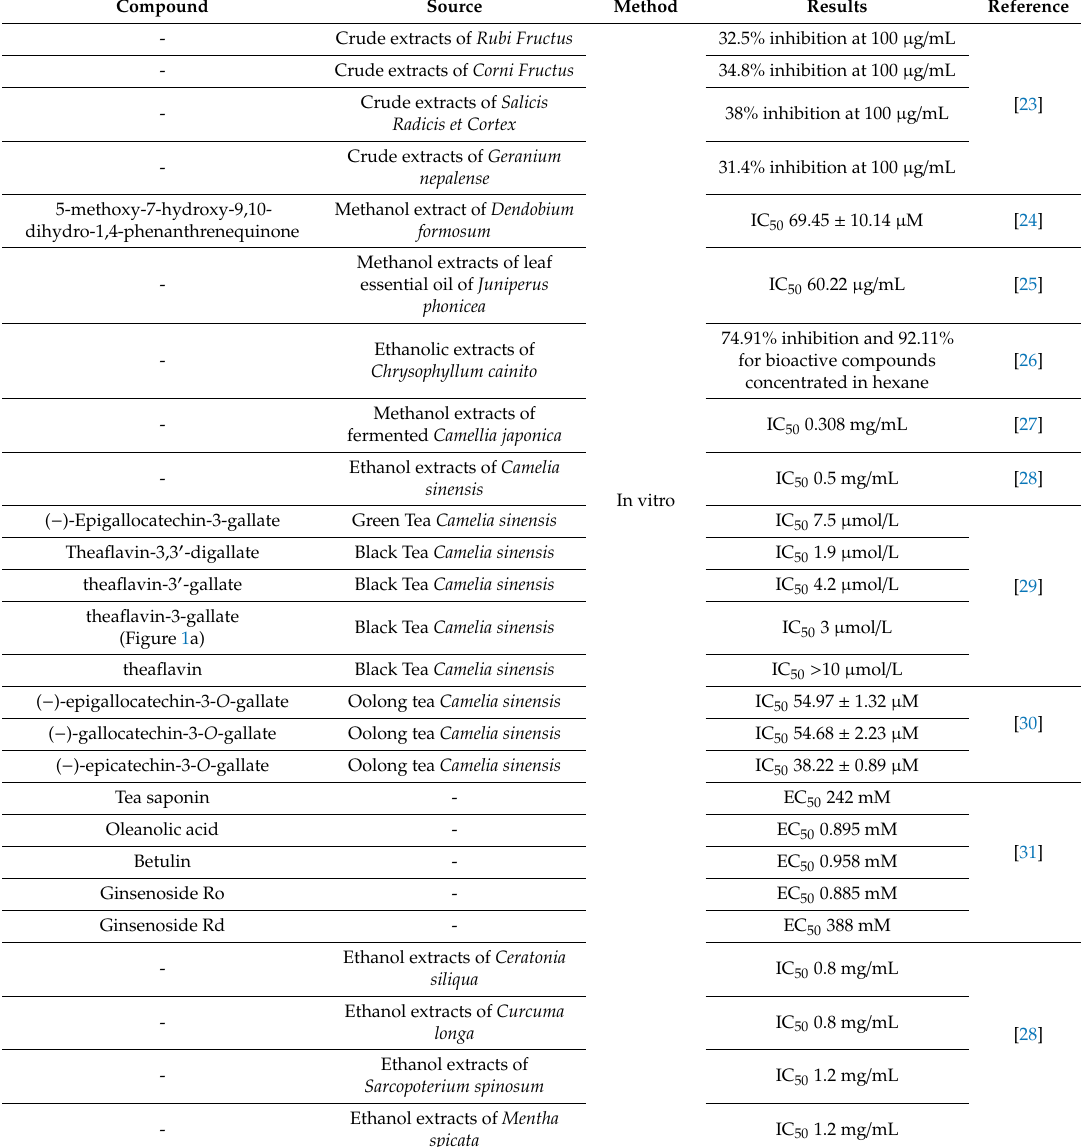
Table 1. Natural lipase